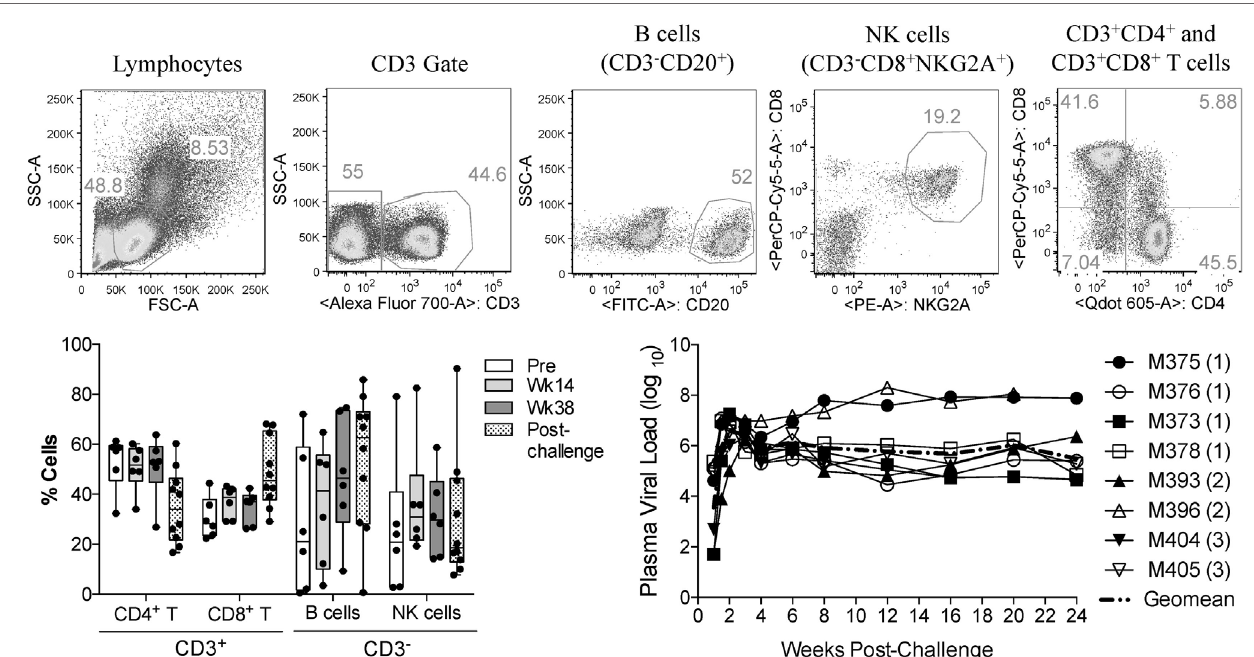
FigUre 1 | immune cell subsets and viral load status of macaque samples used in the present study . Frozen PBMCs from previously vaccinated and SIV mac251 -challenged macaques were thawed and stained with fluorochrome-conjugated monoclonal antibodies. (a) Gating strategy used to identify the proportional abundance of B cells, NK cells, and CD4 + and CD8 + T cells in samples. (B) Distribution of these immune subsets before vaccination (Pre), during vaccination (weeks 14 and 38) and 8–12 weeks after SIV mac251 intrarectal challenge (post-challenge) as determined by flow cytometry. Data are shown as minimum to maximum boxes with all data points represented. (c) Post-challenge viral loads in the eight macaques were used in the present study. Viral load data were taken from the previous report of Demberg et al. (17), and Vaccination group (described in Table 1 ) for each macaque is indicated in